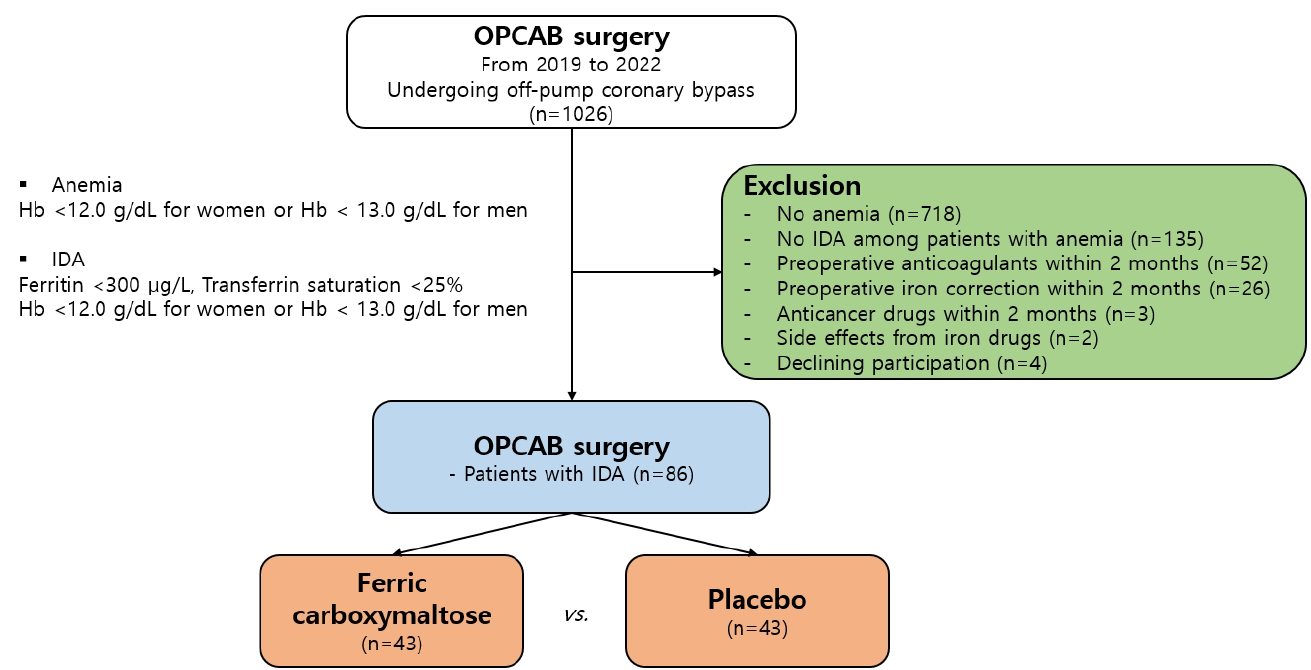
Figure 1. Flow diagram of study sample selection. OPCAB, off-pump coronary artery bypass grafting; IDA, iron deficiency anemia.